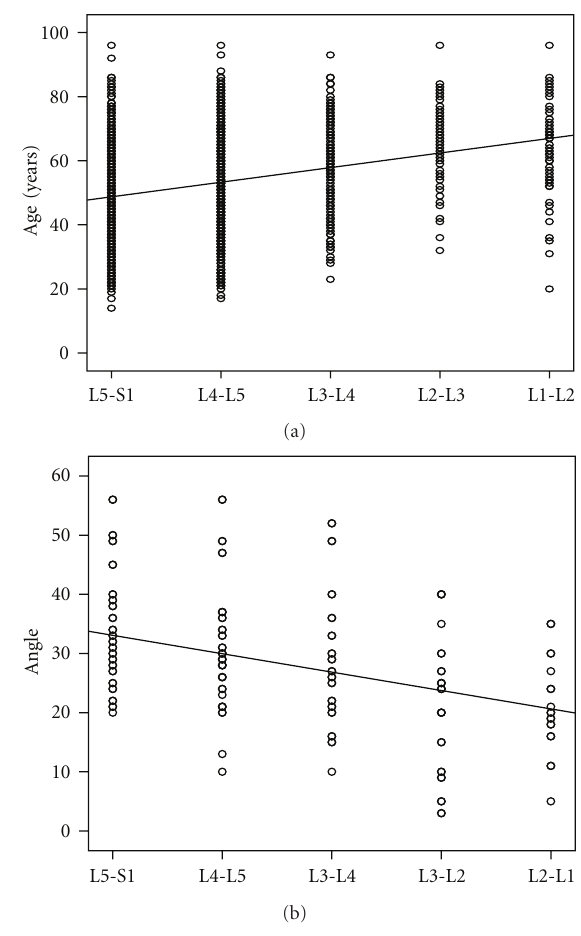
Figure 3: Level of lumbar disc herniation versus age and lumbar lordotic Cobb’s angle. (a) The numbers in the figure correspond to di ff erent mean ages ( ± SEM) with respect to disc herniation levels. There is a significant increase in age as the lumbar disc herniation moves in the cranial direction. (b) The numbers in the figure corre- spond to the measured mean angles ( ± SEM) at di ff erent lumbar levels. The angle tends to decrease according to the lumbar disc herniation level in the cranial